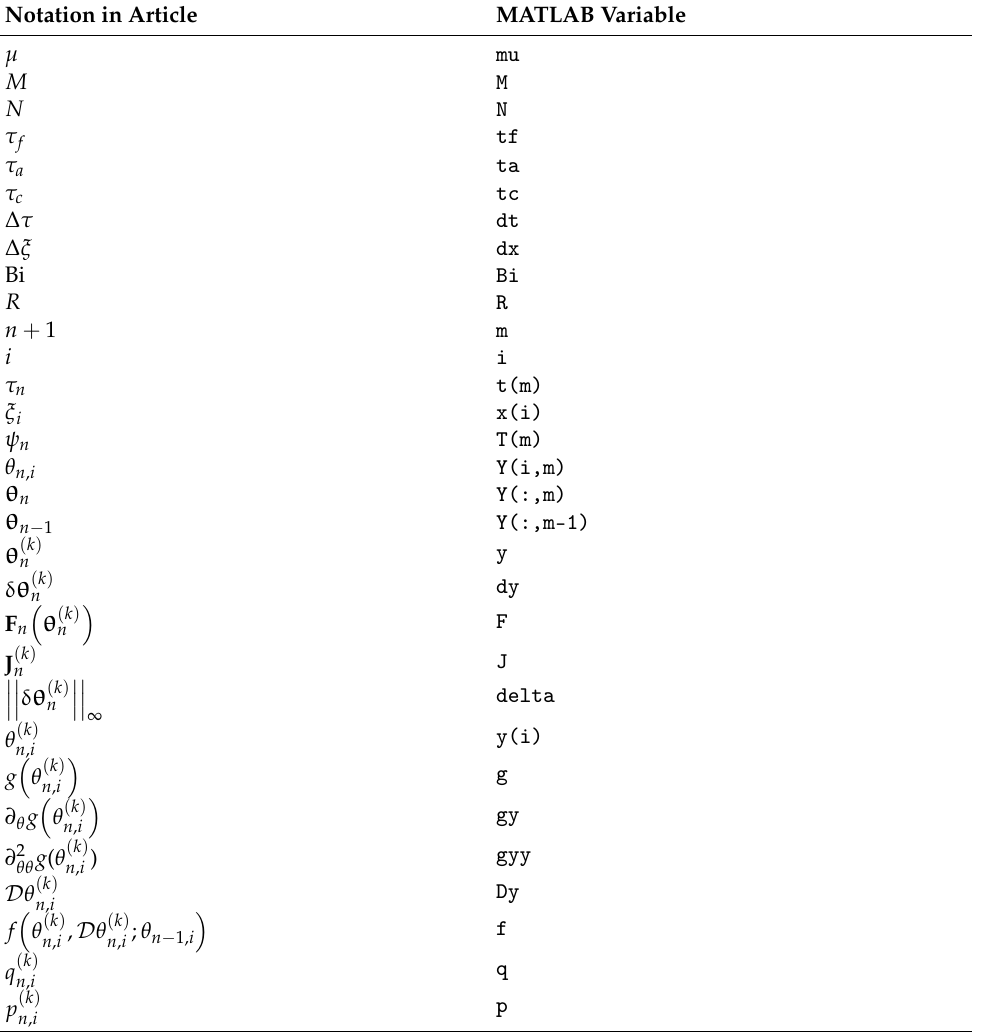
Table A1. Notation and corresponding MATLAB